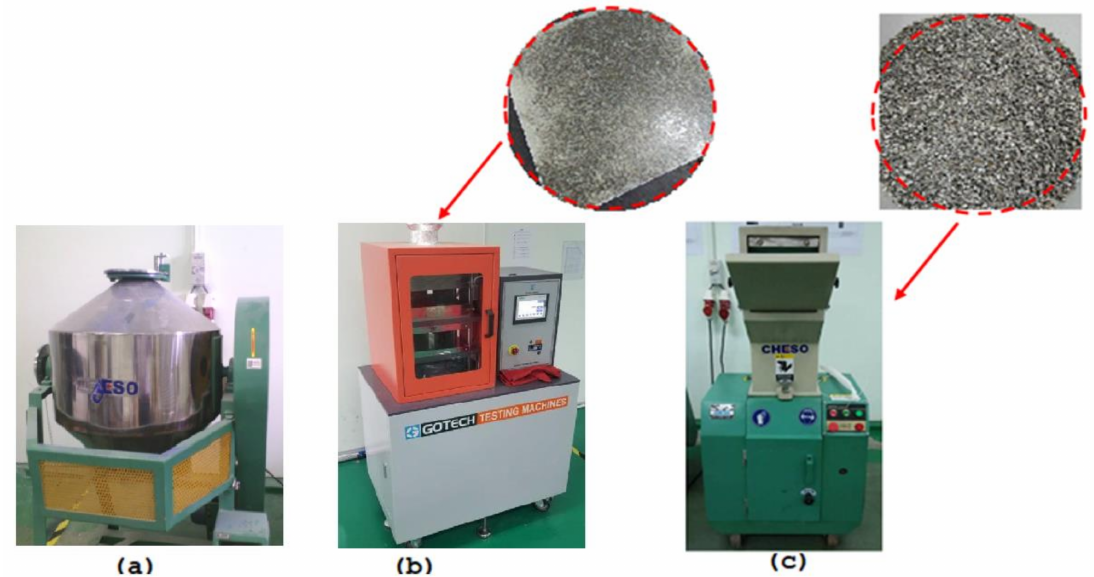
Figure 3. Some of the machines used for producing the oil-palm-fiber-mixed ABS plastic in granule form: ( a ) a mixer, ( b ) a hot pressing machine, and ( c ) a